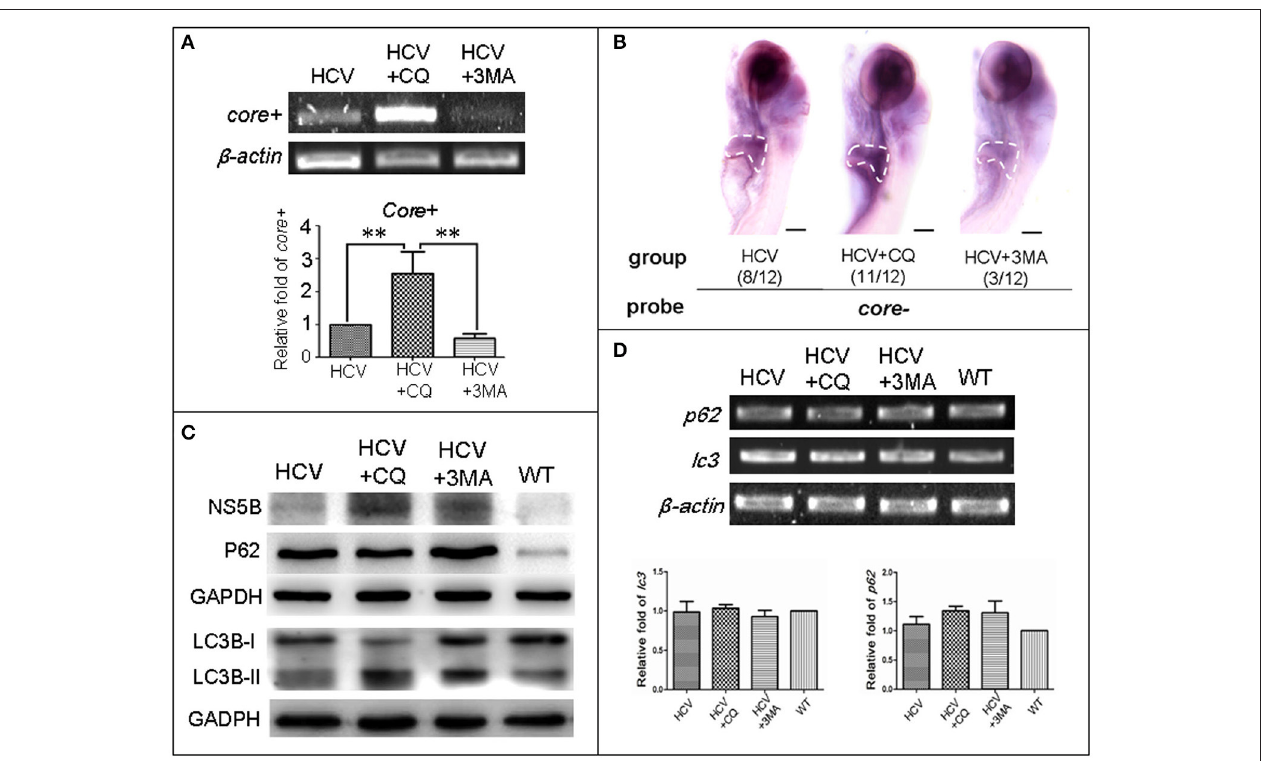
FIGURE 3 | Autophagy affects the replication ability of the HCV subreplicon model. (A) RT-PCR test was used for quantification of the core + level in unexposed HCV model larvae (HCV), HCV model larvae exposed to either CQ (50 µ M) or 3-MA (5mM). β -actin was used as a sample loading control. Histogram shows relative core + / β -actin ratios from three independent experiments. Data are expressed as means ± SD . ** p < 0.01. (B) Whole Mount in situ Hybridization (WISH) indicate that the strongest core + signal is in HCV model larvae exposed to CQ, the second one in the unexposed HCV model larvae and the lowest in the HCV model larvae exposed to 3-MA. The fraction numbers in brackets show the positive number and the total number of larvae being observed in the three groups. Scale bars represent 150 µ m. (C) Western blot showing the protein levels of HCV-NS5B and autophagy flux marker P62 and LC3B-II/I in the unexposed HCV model larvae (HCV), the HCV model larvae exposed to either CQ (50 µ M) (HCV + CQ) or 3-MA (5mM) (HCV + 3MA), and wild type larvae (WT). GADPH was used as a sample loading control. (D) Transcription levels of p62 and lc3b genes were detected via RT-PCR tests, and were not significantly different across the four groups of larvae. All larvae were